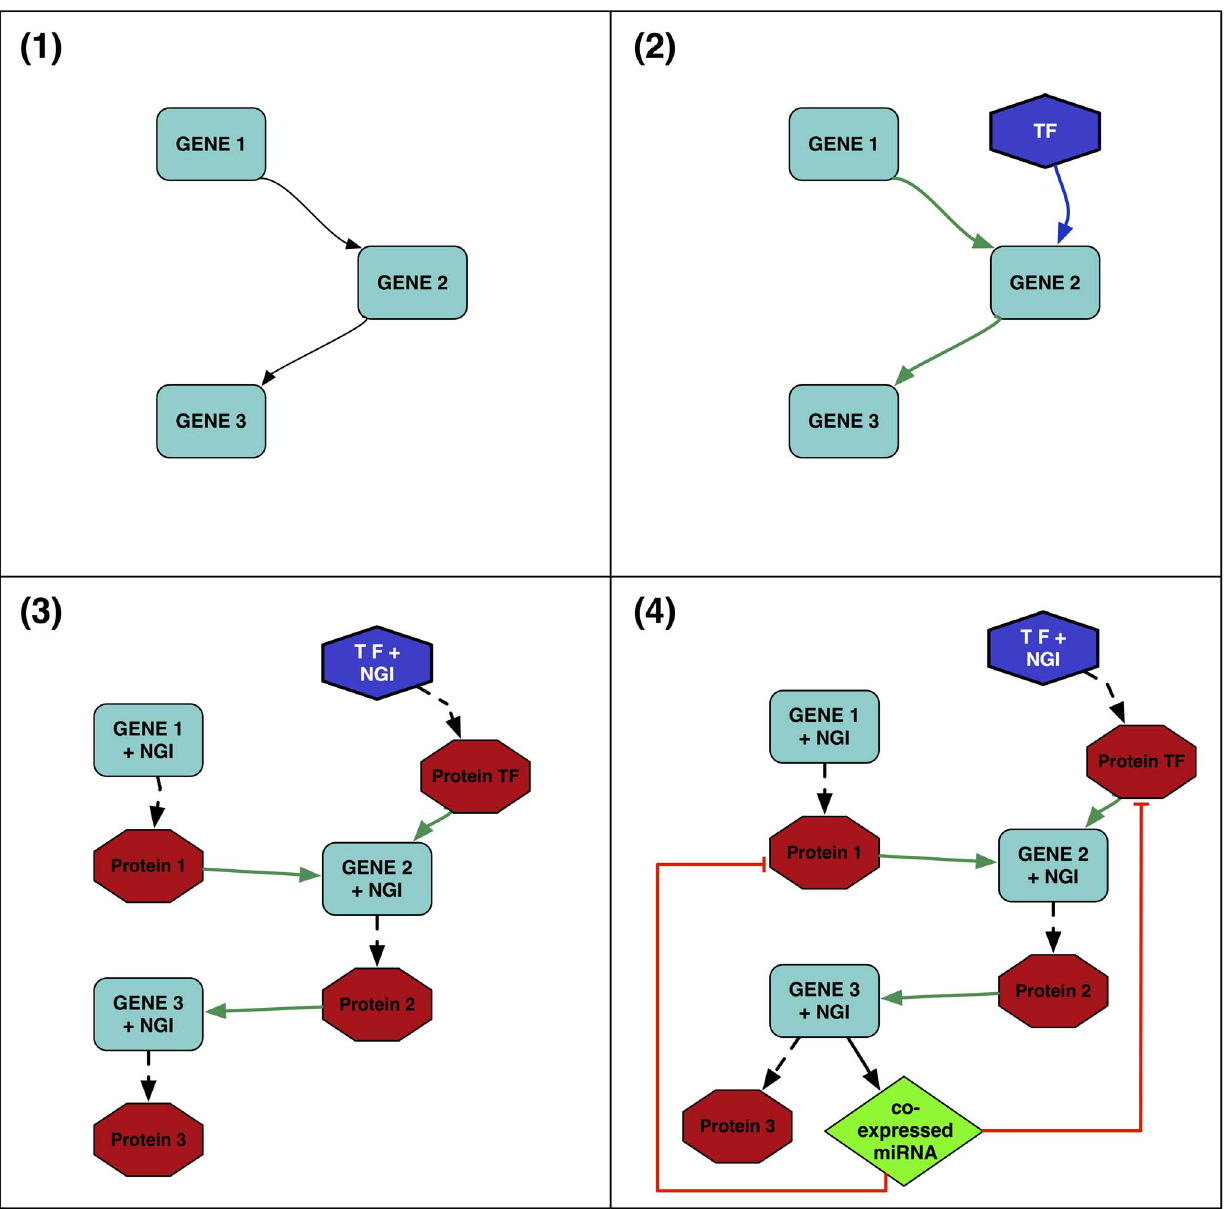
Fig. 3. The image shows the set of enhancing steps automatically performed by ReNE. (1) The original regulatory network. (2) Transcriptional regulation enhancement: Transcription Factors coding genes are added to the network. (3) Translation regulation enhancement: genes are normalized in terms of symbols and accessions retrieving information from NCBI, while the network is enhanced with the protein coded by the genes retrieving information from Uniprot. (4) Post-transcriptional regulation enhancement: each gene is analyzed for discovering possible co-expressed intragenic miRNAs. For each miRNA, the list of its target genes is intersected with the network entities, and for each match the network is enhanced with a regulatory edge.